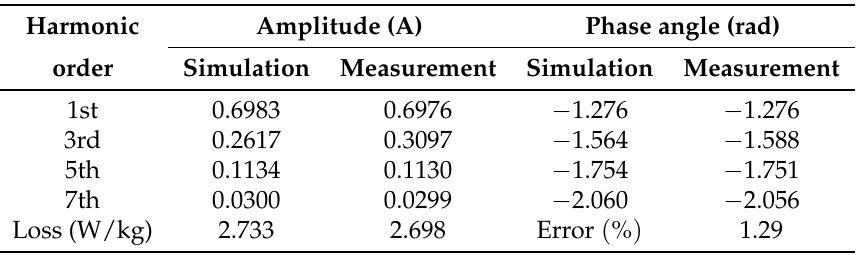
Table 3. Results of square excitations (1.5 T, 50